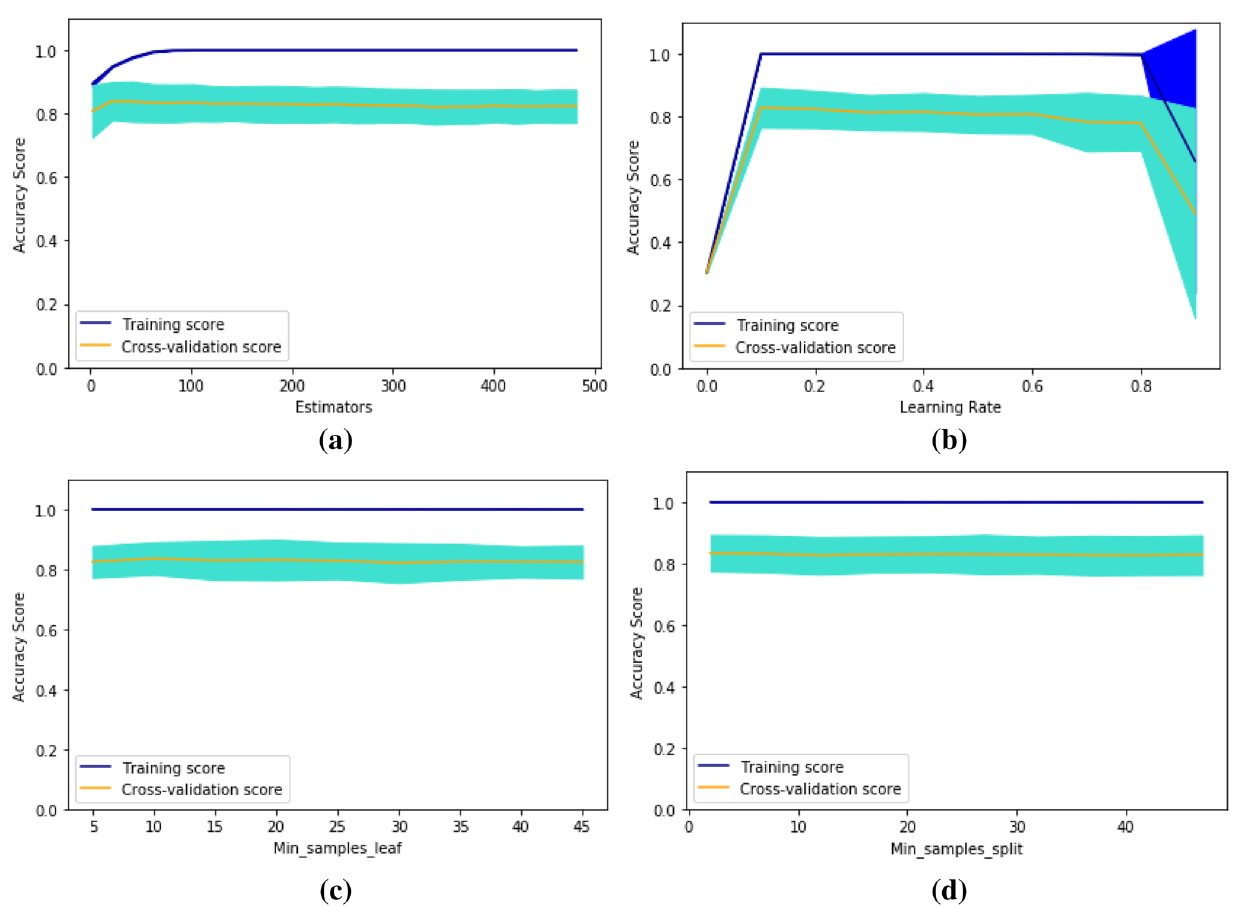
Fig. 7 Validation curves of gradient boosting classifier to identify stable search range for four primary model variables. a Number of estimators, b learning rate, c minimum samples required at a leaf node and (d) minimum samples required for splitting the internal